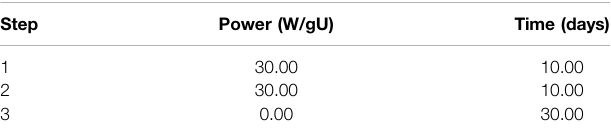
TABLE 7 | Power history of simpli fi ed VERA problem 10. TABLE 8 | Decay step calculational times using various